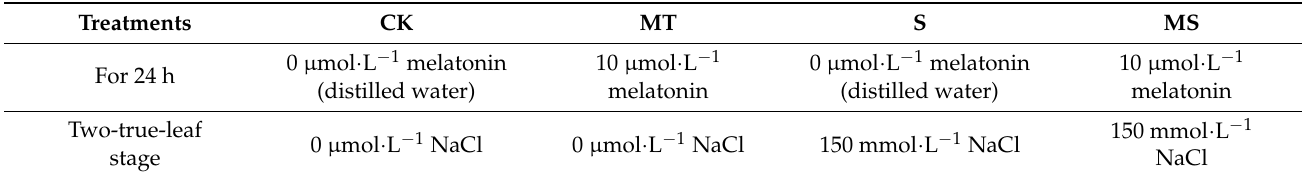
Table 1. Experimental treatment with control conditions (CK), melatonin (MT), NaCl (S) and both melatonin and NaCl